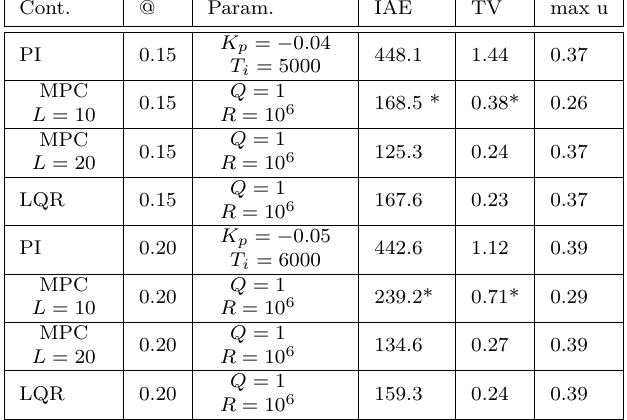
Table 2: Summary: Comparing controllers PI, MPC and LQR by performance measures IAE and TV, calculated from k = 200 to k = 800. , Maximum choke opening while stable is do- L nated by max u. Measures donated by